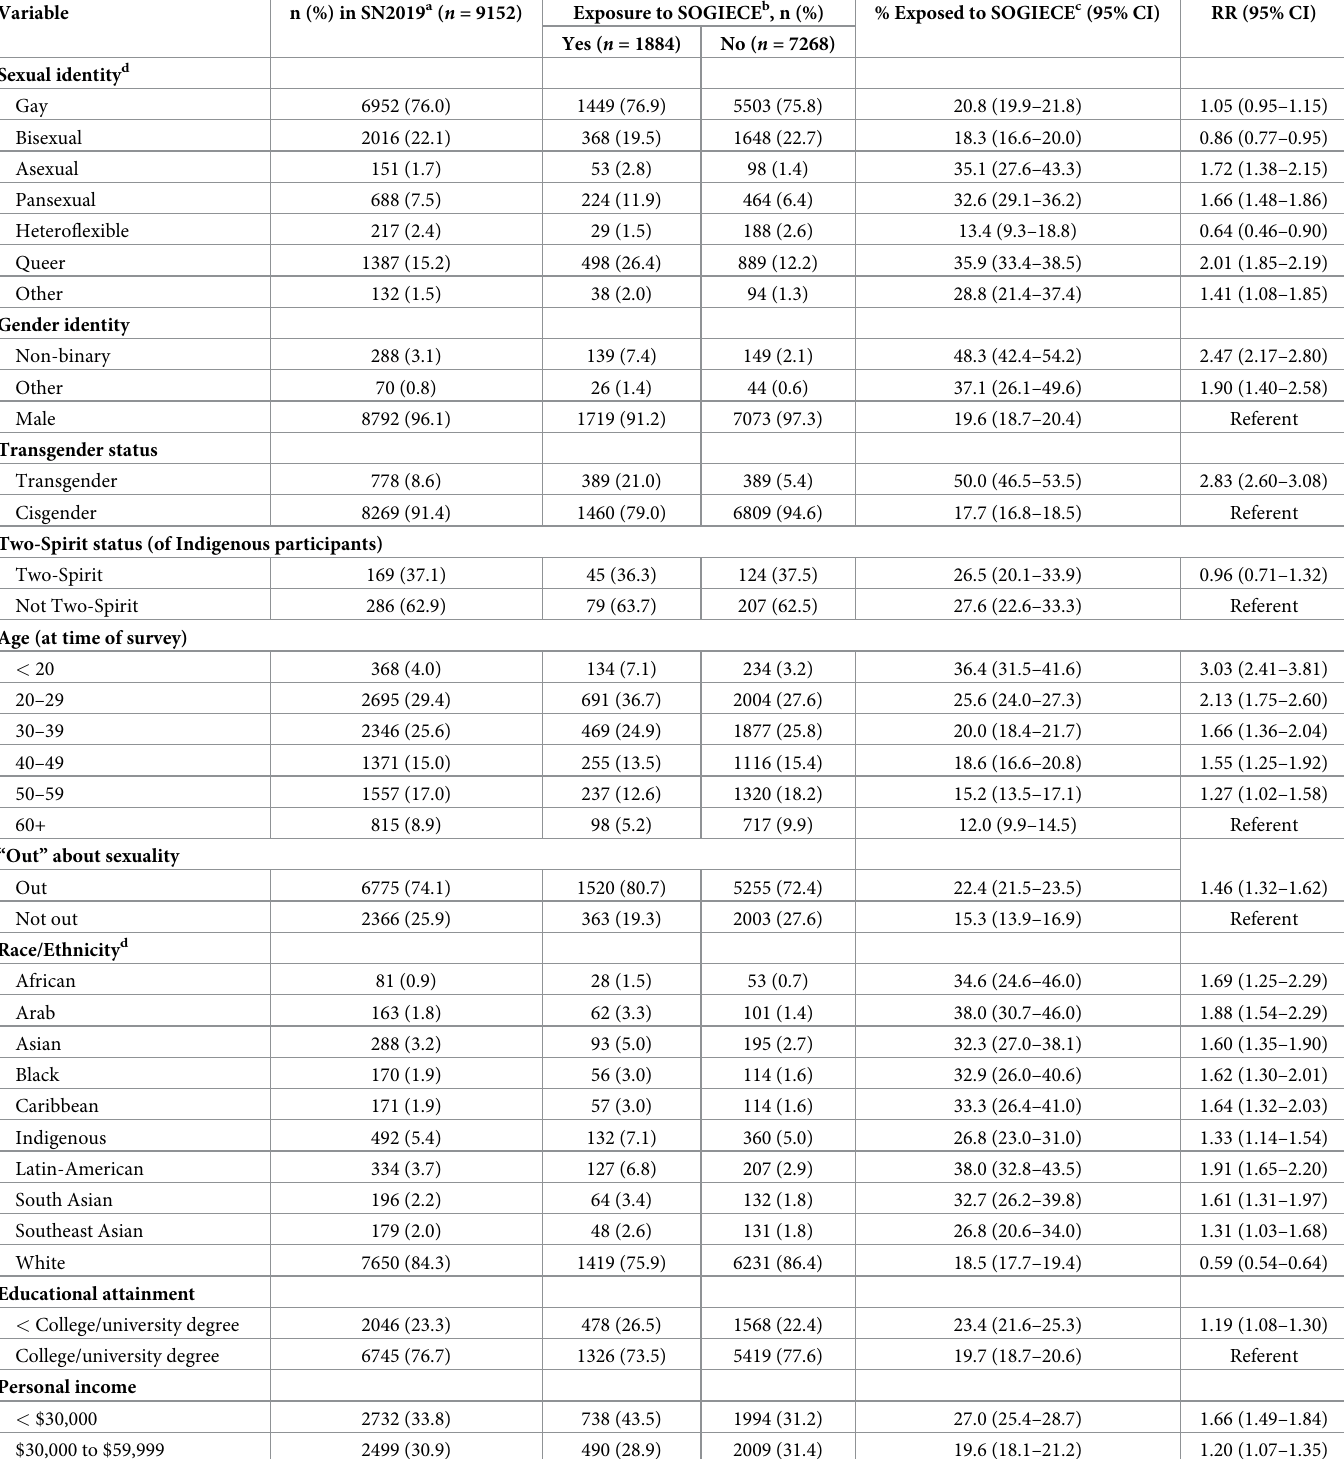
Table 2. Lifetime prevalence of exposure to Sexual Orientation and Gender Identity Change Efforts (SOGIECE) among sexual and gender minority Canadian men, by sociodemographic subgroups,